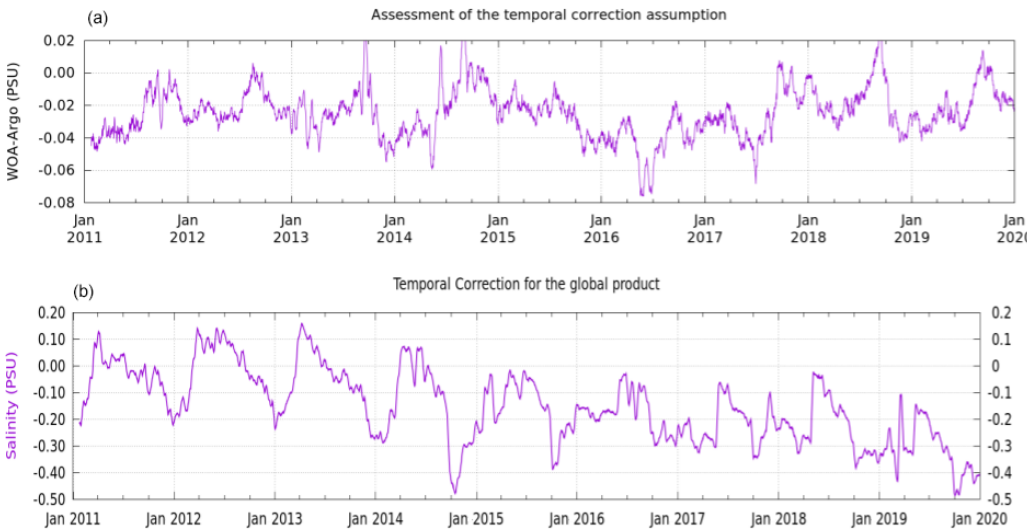
Figure 1. (a) Assessment of the temporal correction assumption: the graphic represents the mean average of the difference between a constant annual salinity reference (the World Ocean Atlas, 2013) and collocated Argo salinity measurements. (b) Temporal correction applied to the BEC SSS